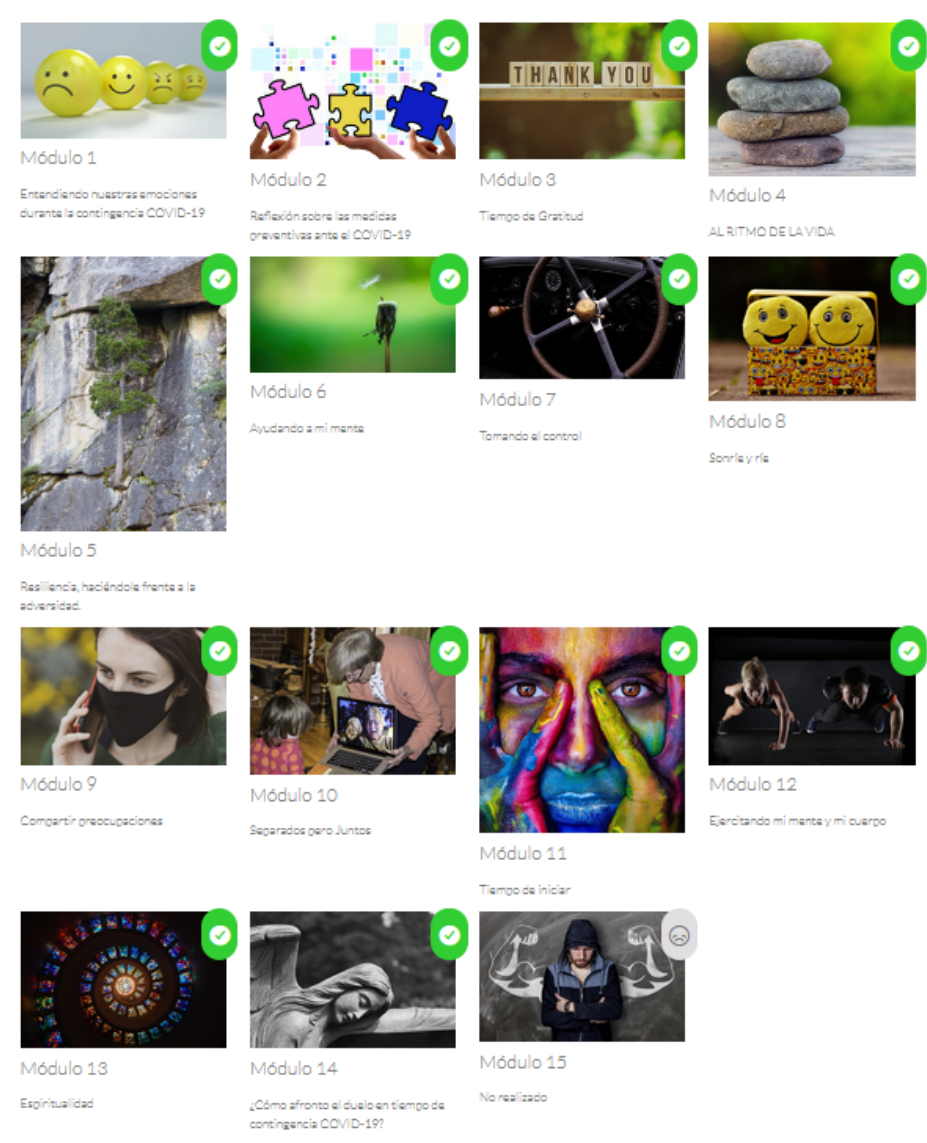
Figure 3. Menu showing the modules completed by the